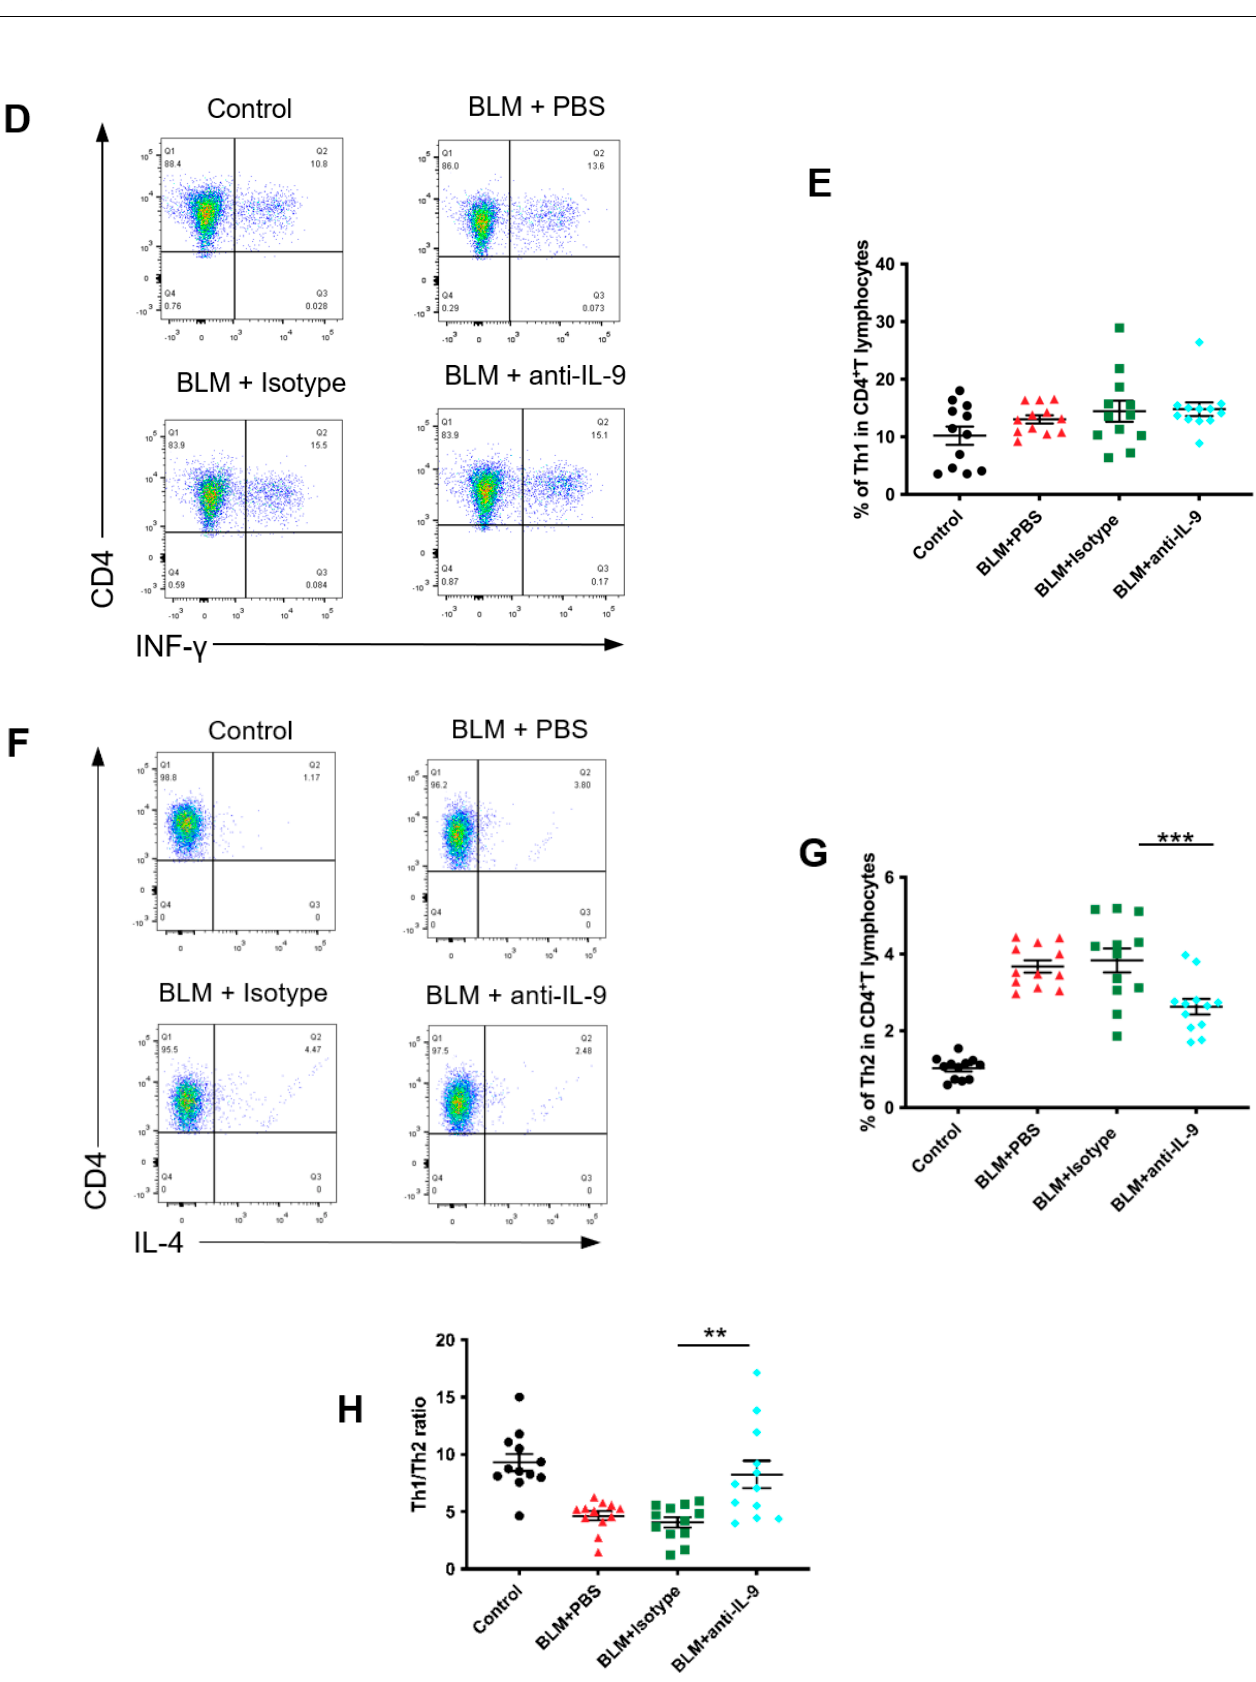
Figure 6. Effects of IL-9 neutralizing antibody on the ratio of Th9 cells, Th2 cells, and Th1/Th2 in lung lymphocytes of BLM-induced pulmonary fibrosis mice (preventive intervention). ( A ) Flow cytometric analysis of INF- γ , IL-4, and IL-9 in the mice lung tissue. Gating strategy was used to identify Th1, Th2, and Th9 cells in the lungs of mice (CD4 + IL-9 + T cells